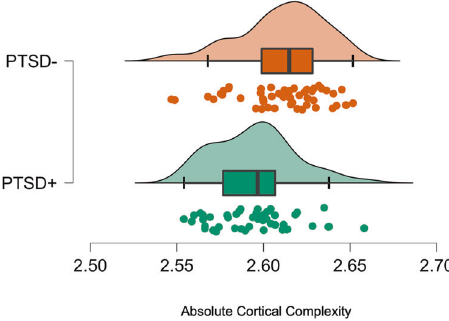
Fig. 2 Raincloud plots showing data distribution (cloud), jittered raw data and central tendency boxplots comparing absolute cortical complexity between WTC responders with PTSD versus those without. Analyses identi fi ed signi fi cantly lower absolute whole brain cortical complexity (Welch ’ s t = − 3.3144, p = 0.0013, Cohen ’ s d = − 0.67) in the PTSD + group (mean = 2.5946, SD = 0.0234), when compared to the PTSD- group (mean = 2.6107, SD = 0.0247). PTSD posttraumatic stress disorder, X-axis denotes whole brain FD.